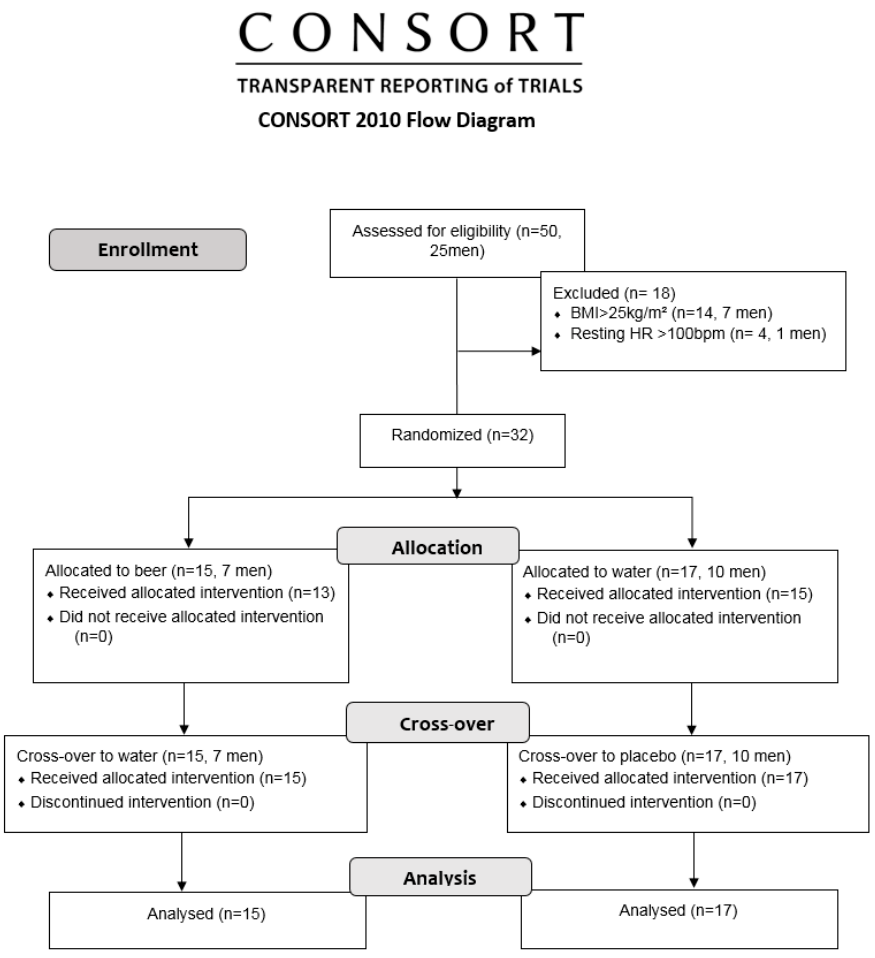
Figure 1. Flowchart representation of the study phases (enrolment, allocation, crossover and analysis).